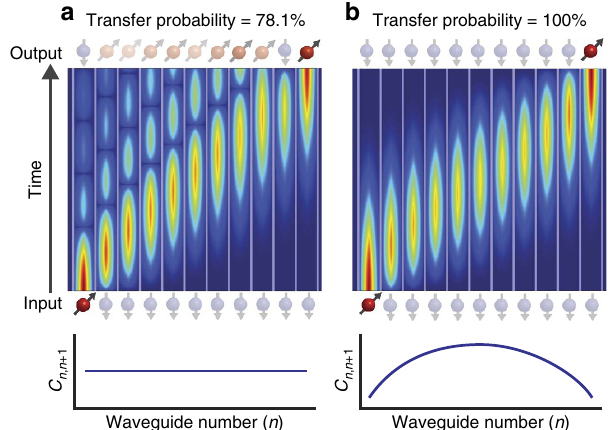
Figure 2 | Propagation simulations with different coupling coefficient spectra. ( a ) A photon is injected into the first waveguide of an array of eleven coupled waveguides with the Hamiltonian in equation (1) and a uniform coupling coefficient spectrum. With the constraint that reflections off boundaries are not allowed, we calculate a maximum probability of transferring the photon to waveguide 11 of 78.1% (ref. 2). ( b ) A photon is injected into the first waveguide of an array of eleven coupled waveguides, this time with the coupling coefficient spectrum of equation (2). After evolution for a pre-determined time, the photon is received at waveguide 11 with 100% probability 3–7